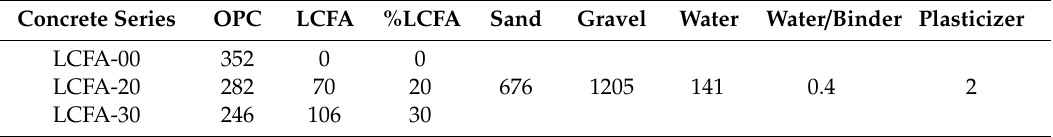
Table 4. Concrete mix design (kg / m 3 ).